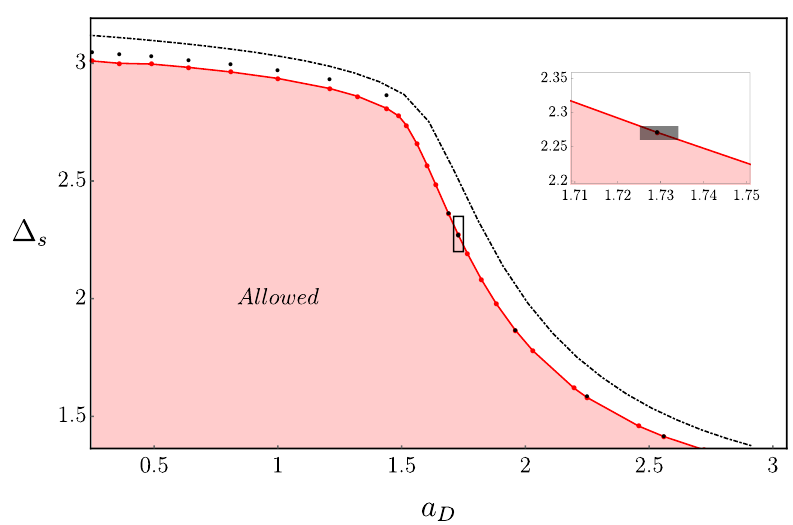
Figure 8 . Maximizing the singlet gap. The red dots represent the bound obtained using GFF functionals with n = 6 (40 components), black dots correspond to n = 2 (16 components). max max The dashed-dotted black line represents the same bound using a derivative basis with 60 compo- nents [25]. The inset shows a zoomed version of the plot around the region where the twist defect is supposed to lie, with the box representing ∆ s = 2 . 27(1)